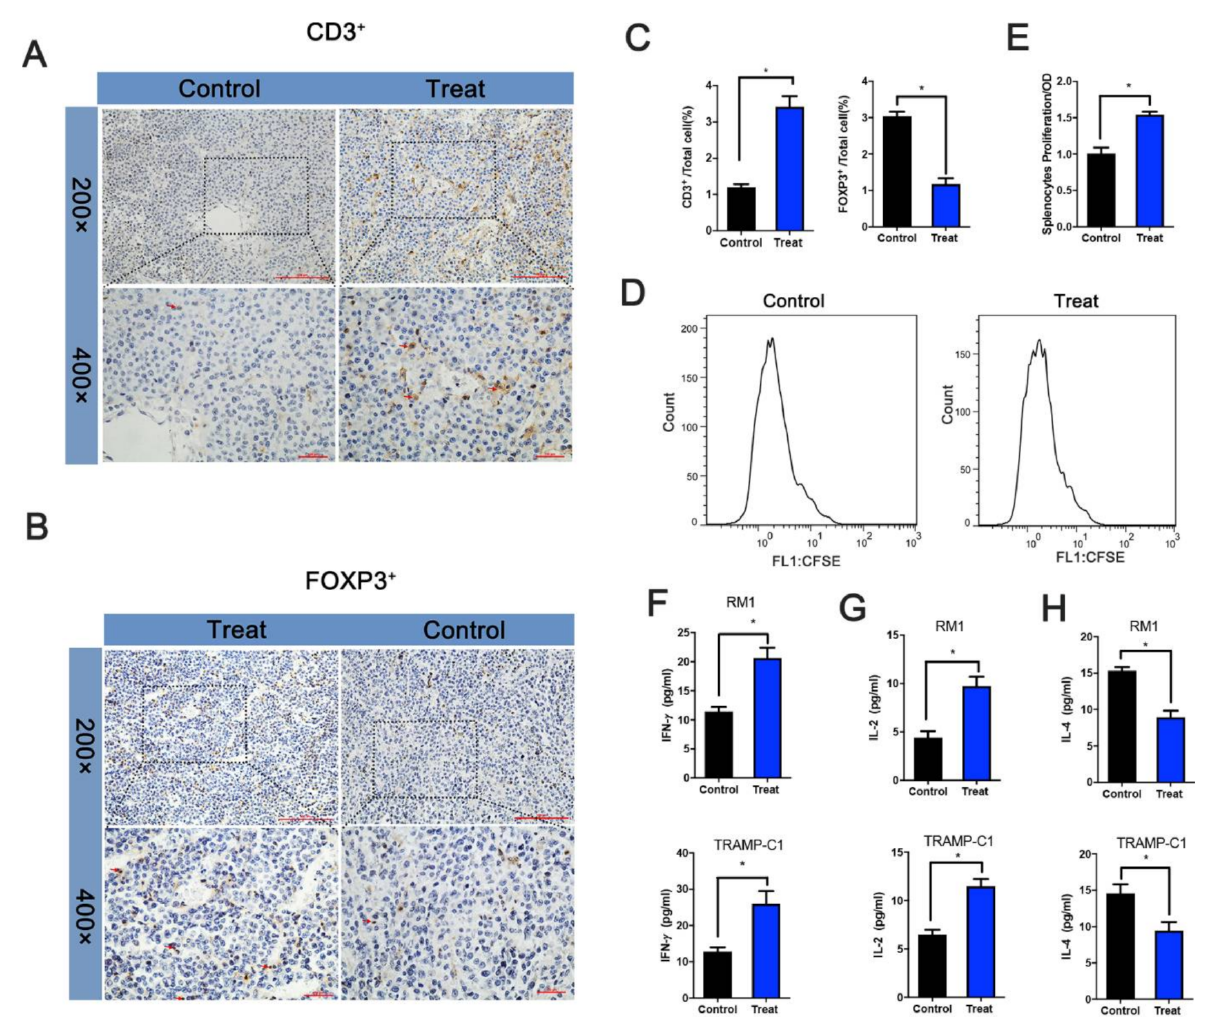
Figure 5. Fusion protein mediated T cell-dependent antitumor effect. ( A ) Distribution of CD3 + cells and FOXP3 + cells. ( B ) in TRAMP-C1 xenograft. ( C ) Statistical analysis of the proportion of positive cells among all cells. ( D ) Spleen cell proliferation assays. After the mice were sacrificed, spleen cells were isolated and labeled with CFSE and incubated with the fusion protein. Cell proliferation was then identified using flow cytometry or CCK8 ( E ). ( F – H ) Determination of IFN- γ , IL-2, and IL-4 in the RM1/TRAMP-C1 xenograft model serum after sacrificing the mice. * p <